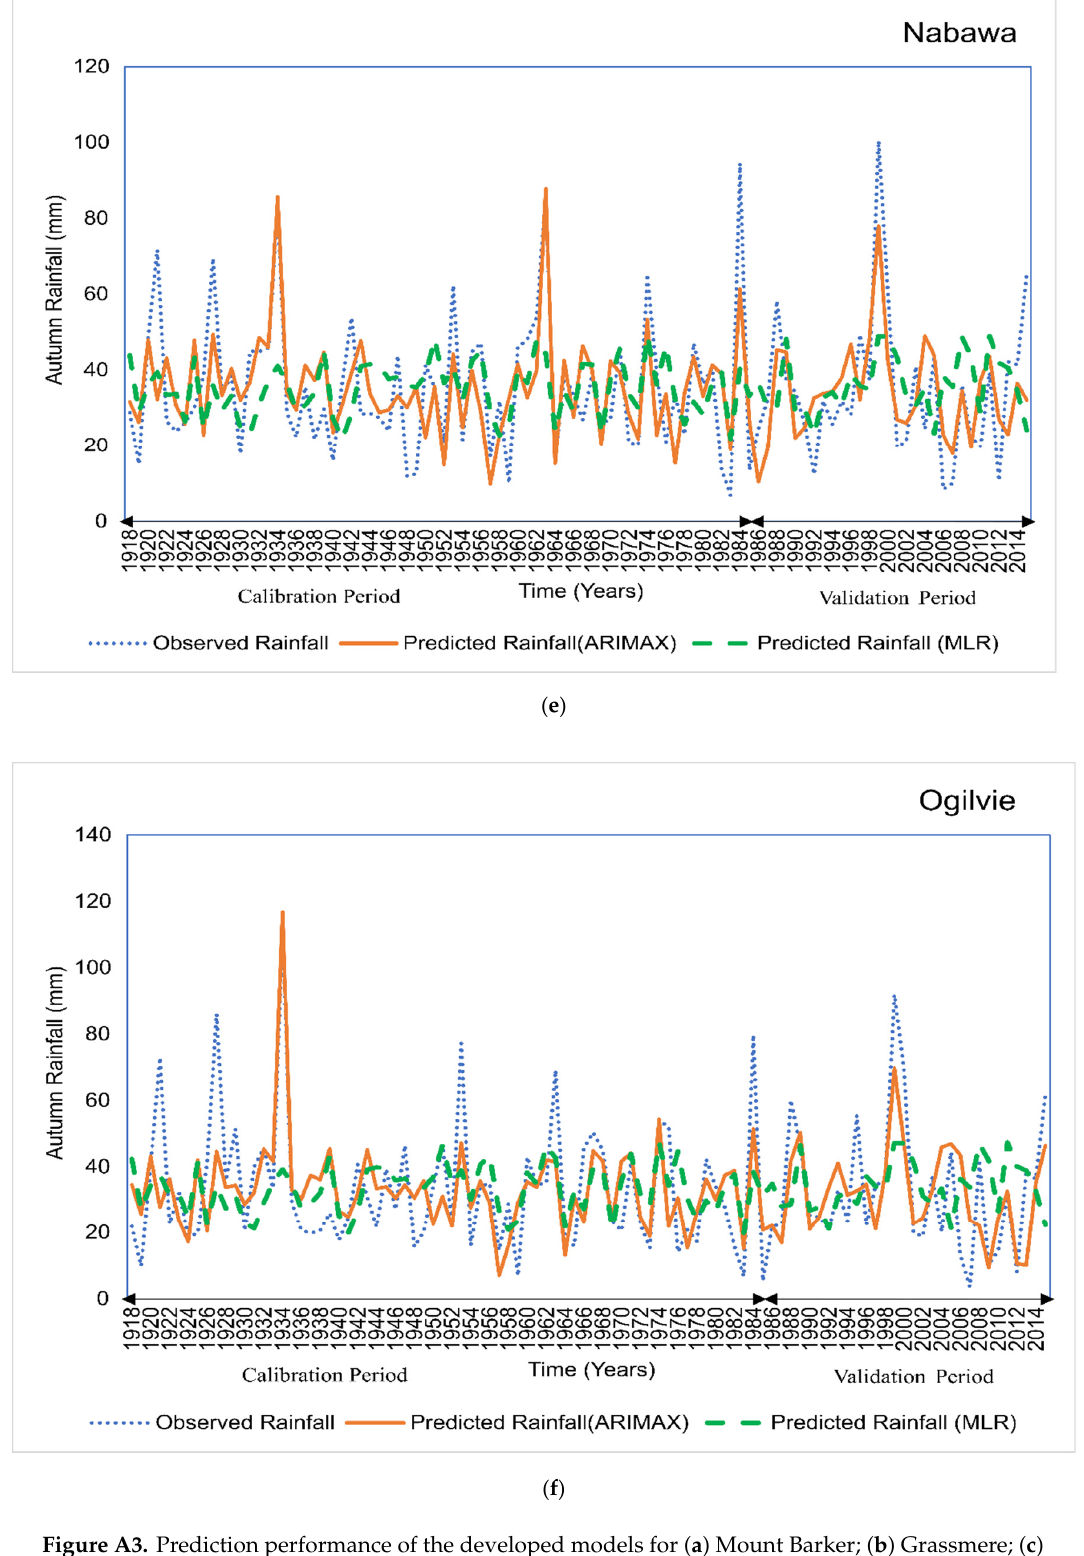
Figure A3. Prediction performance of the developed models for ( a ) Mount Barker; ( b ) Grassmere; ( c ) Busselton Shire; ( d ) Mingenew; ( e ) Nabawa; ( f ) Ogilvie.